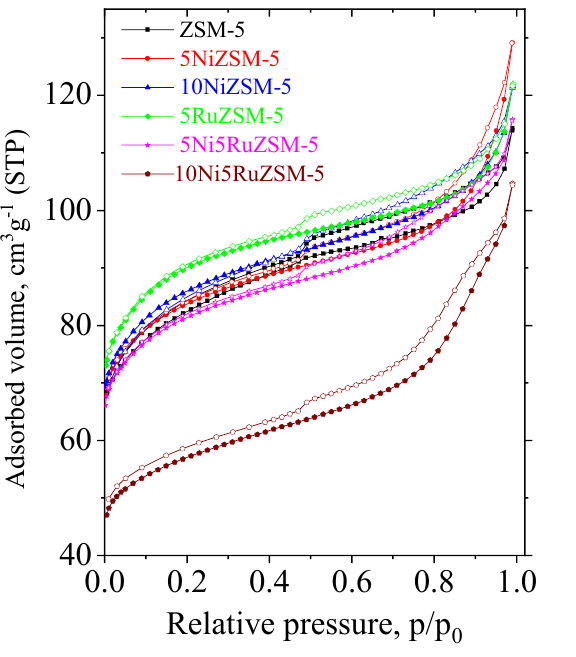
Figure 2. Nitrogen adsorption/desorption isotherms of ZSM-5 and the Ni- and Ru-modified ZSM-5 zeolites.